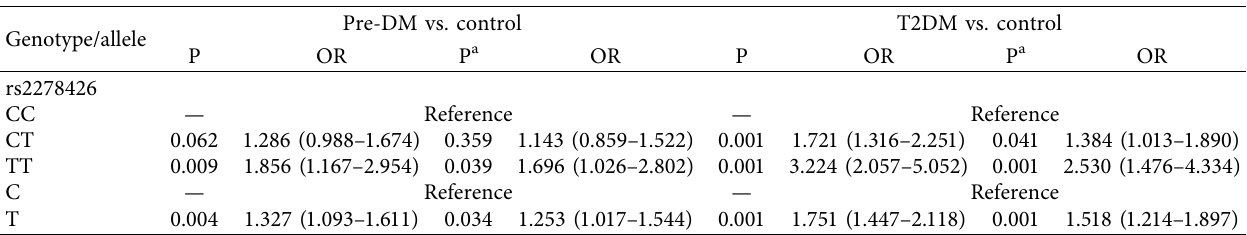
Table 3: Odds ratios of having each genotype and allele of the ANGPTL 8 rs2278426 (C/T) polymorphism in the study